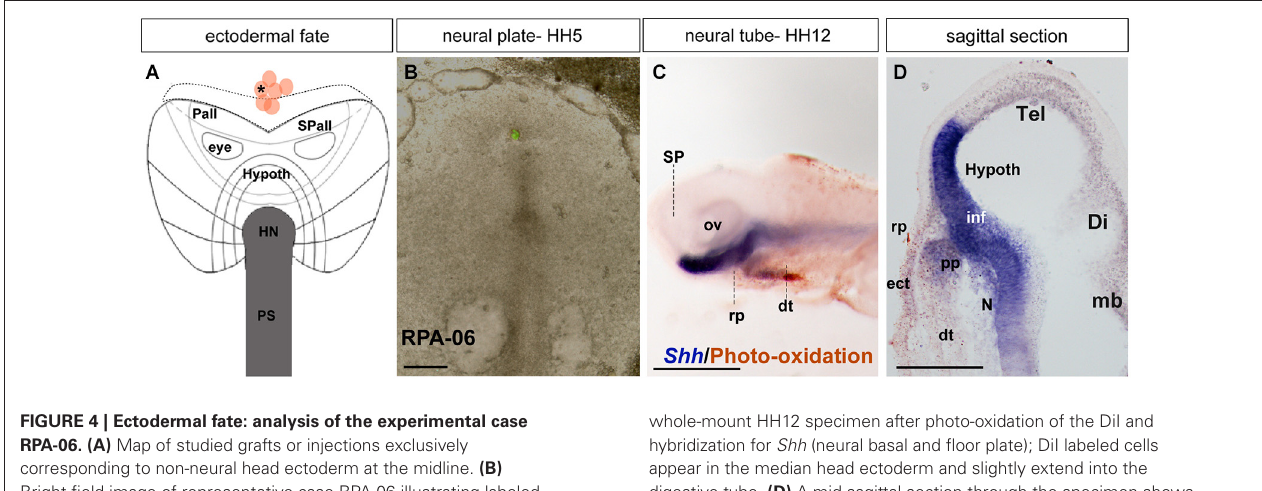
FIGURE 4 | Ectodermal fate: analysis of the experimental case RPA-06. (A) Map of studied grafts or injections exclusively corresponding to non-neural head ectoderm at the midline. (B) Bright-field image of representative case RPA-06 illustrating labeled cells (corresponding to dark dot in A ) located largely in the rostral ectoderm beyond the ADH field locus. (C) Side view of the